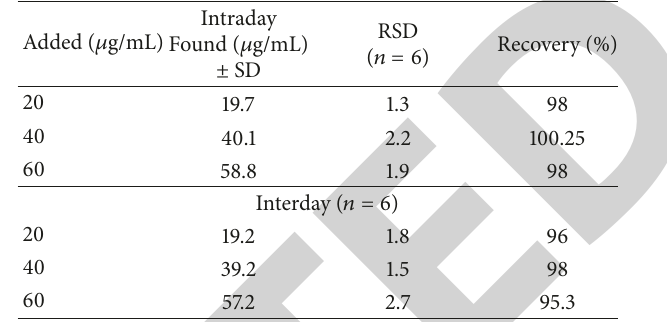
Table 2: Intraday and interday precision studies for the determina- tion of GSH using